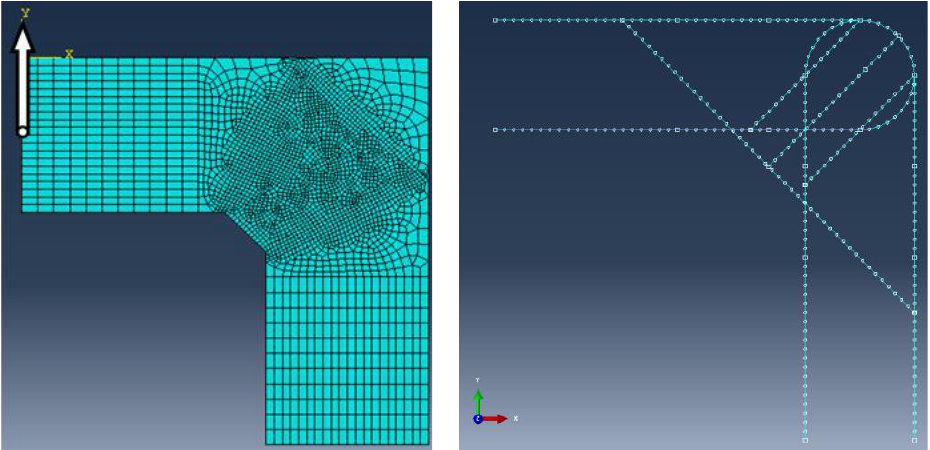
Figure 18. Meshing of concrete and reinforcing steel (detail NO. 7) and analyzed nodal displace- ment.